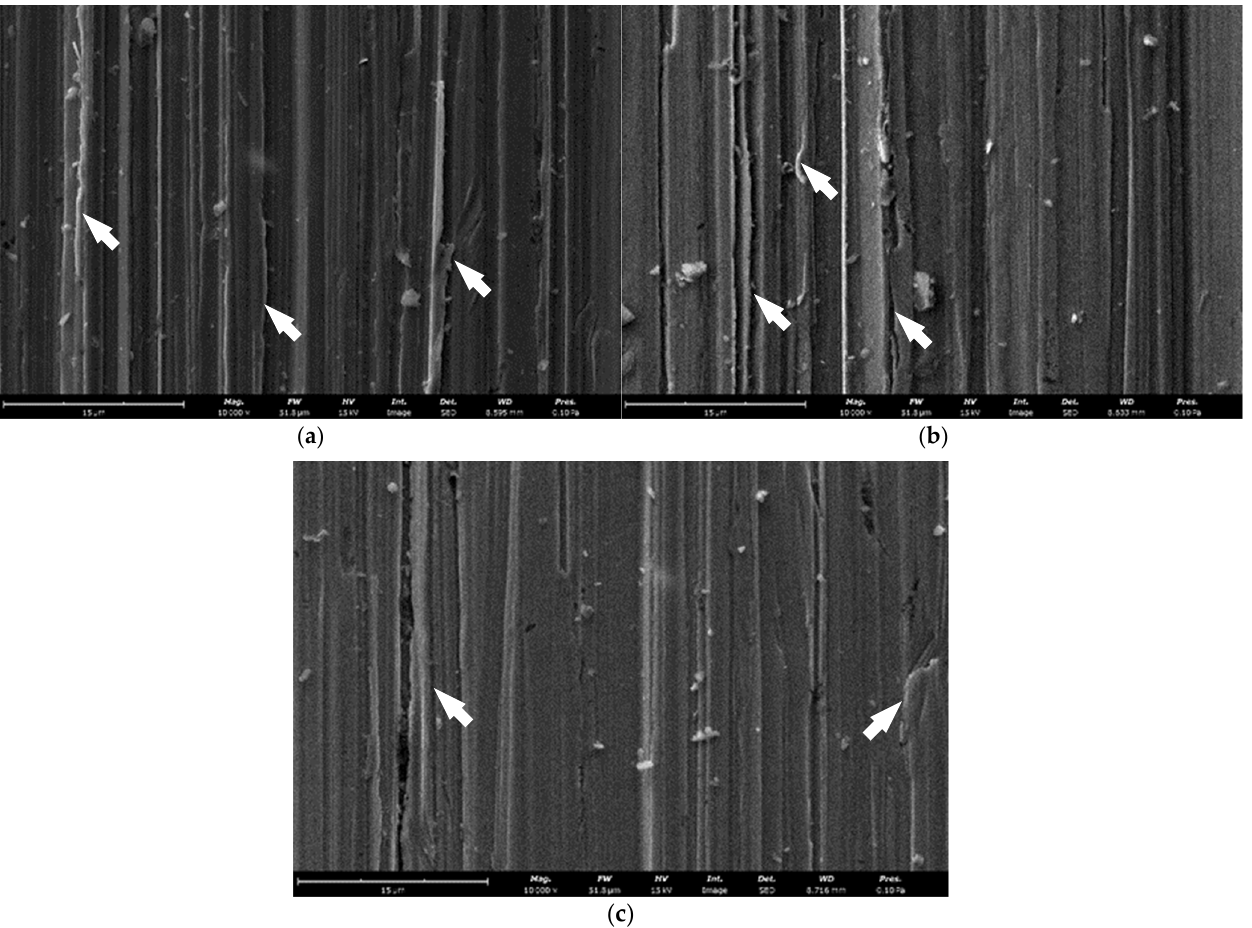
Figure 15. Morphology of the specimen surface after the abrasive wear test: ( a ) delivery condition; ( b ) after isothermal annealing at 510 °C; ( c ) after re-austenitisation at 900 °C (arrows indicate plastic deformation of the material caused by microploughing). SEM (SE).